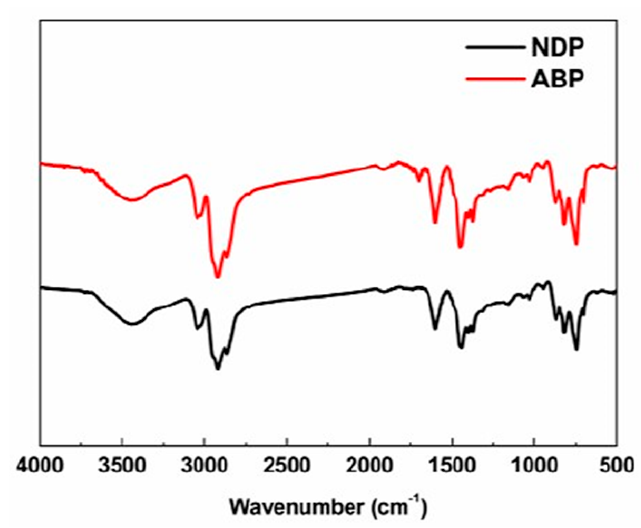
Figure 2. FT-IR spectra of the NDP and the ABP.